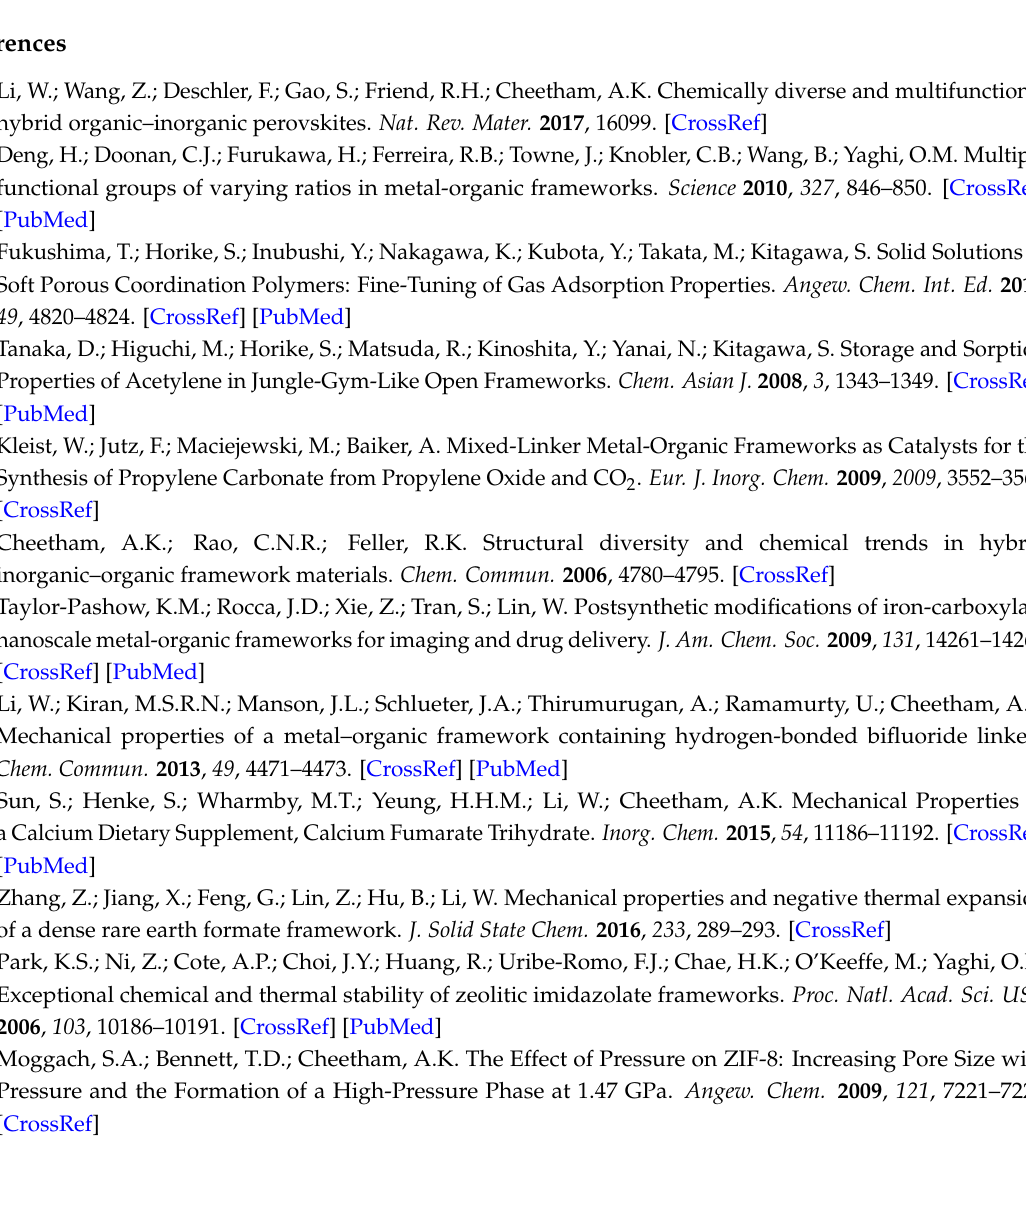
Figure S1: The powder X-ray diffraction (PXRD) spectra of MAF-7 refined by Le Bail method. The black and red symbols, and the purple continuous lines are experimental, calculated, and difference profiles, respectively, and the vertical markers indicate the allowed Bragg reflections. Rp = 5.0%, Rwp = 7.4% and GOF = 4.598; Table S1: Lattice parameters and unit cell volume of MAF-7 at various pressure